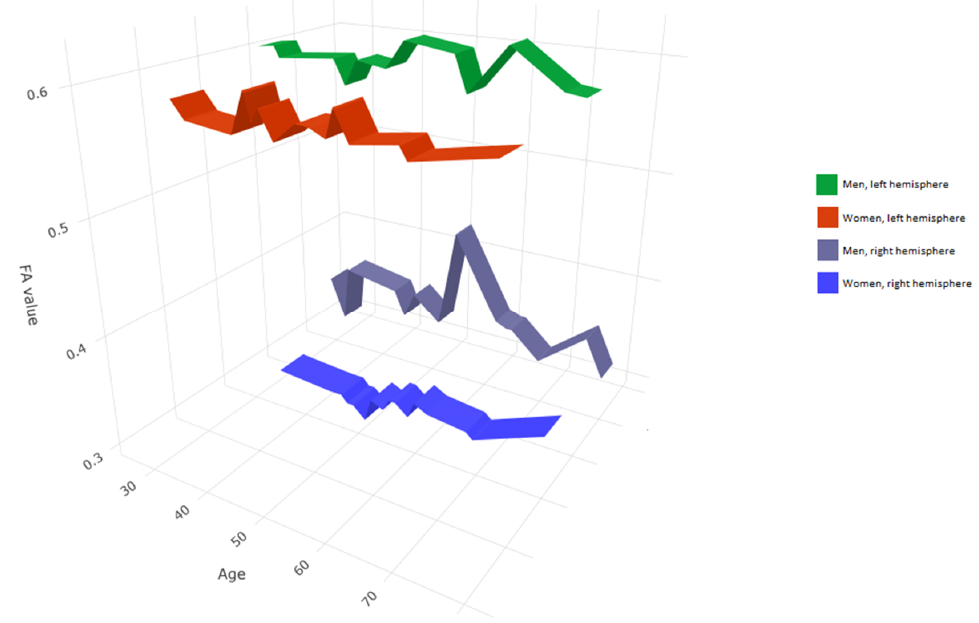
Figure 9. Correlation between FA value, sex, and age in the right and left hemisphere for the group of 34 patients aged 25–82.